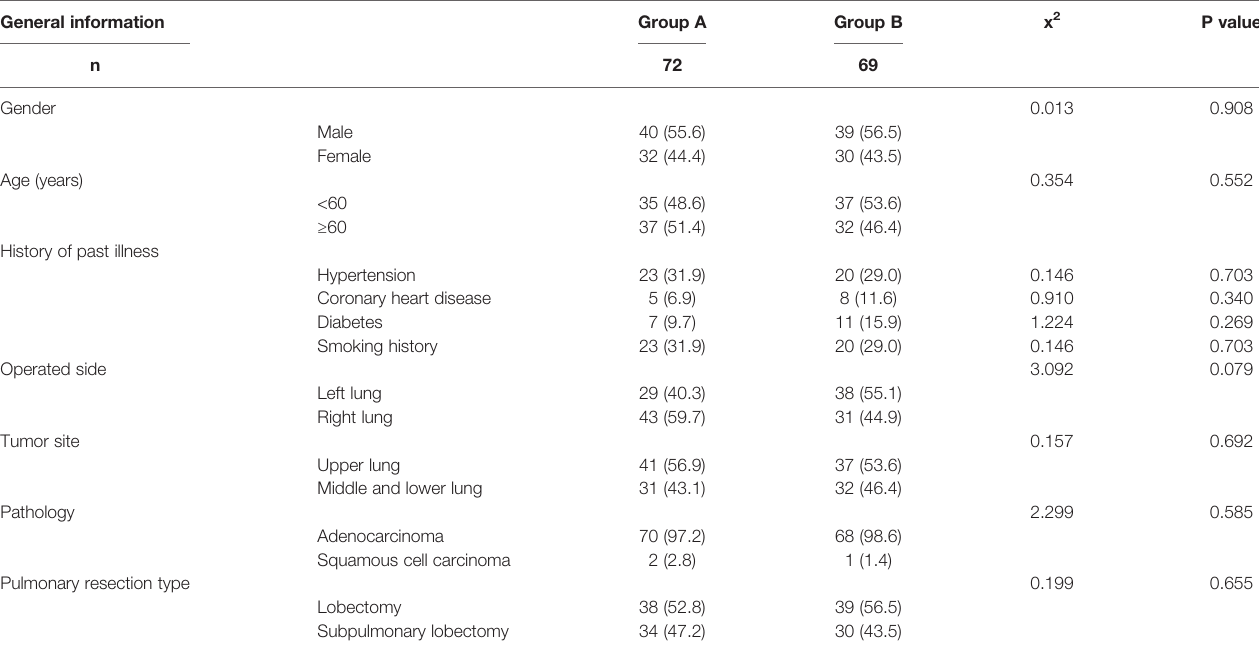
TABLE 1 | Comparison of preoperative general data between the two groups. General